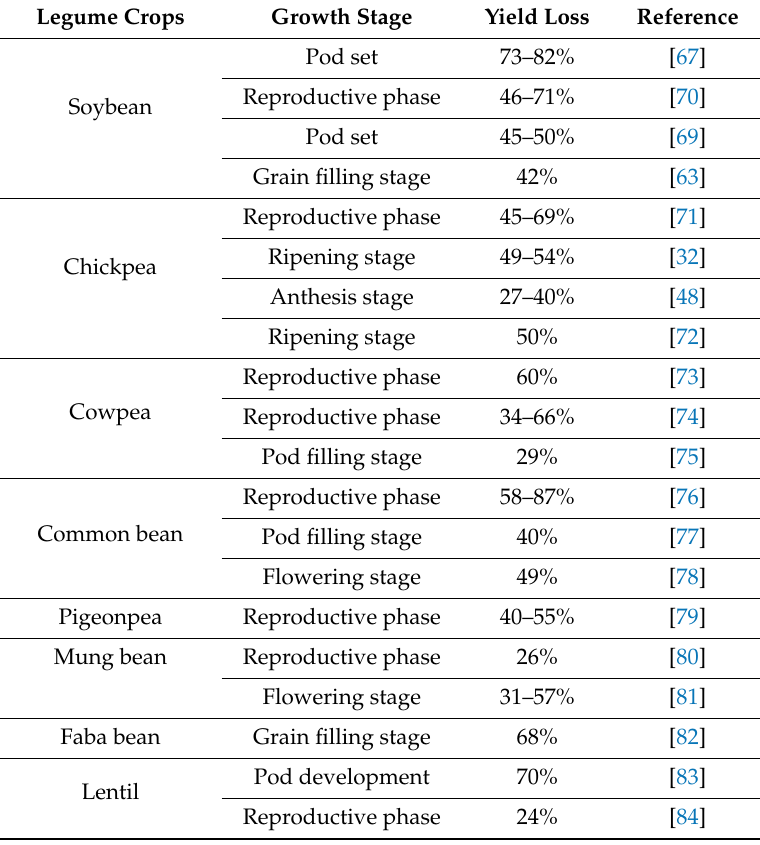
Table 1. Yield losses (%) in important legumes under drought stress